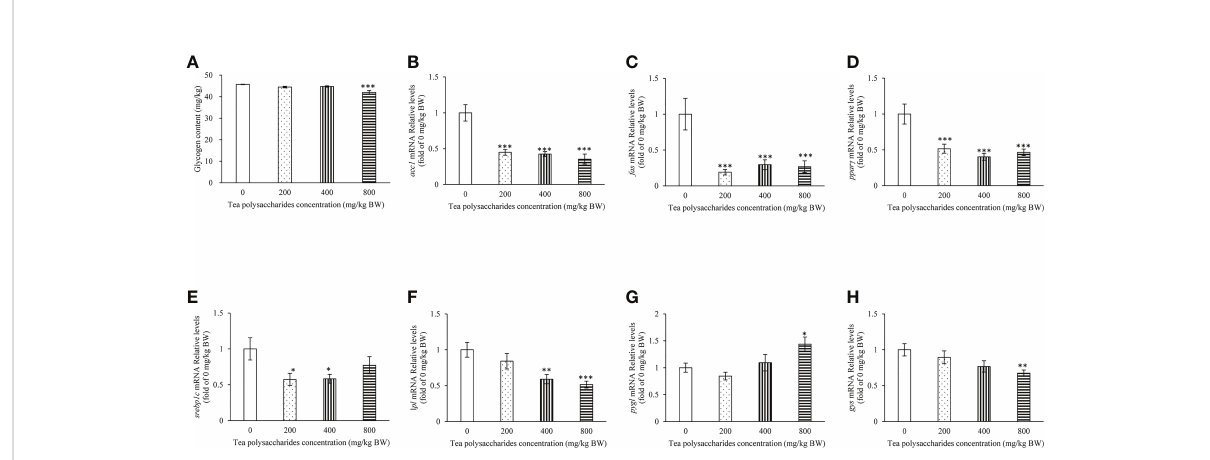
FIGURE 1 Effects of tea polysaccharides on hepatopancreas glycogen content and genes expression related to lipid metabolism in hepatopancreas. (A) Hepatopancreas glycogen content. At end of the experiment, fi sh were killed and the hepatopancreas was collected for glycogen content detected. (B – H) genes expression related to lipid metabolism in hepatopancreas. (B) acc1 ; (C) fas ; (D) ppar g ; (E) srebp1c ; (F) lpl ; (G) pygl ; (H) gys . At end of the experiment, fi sh were killed and the hepatopancreas was collected for RNA extraction and real-time PCR. All data are shown as